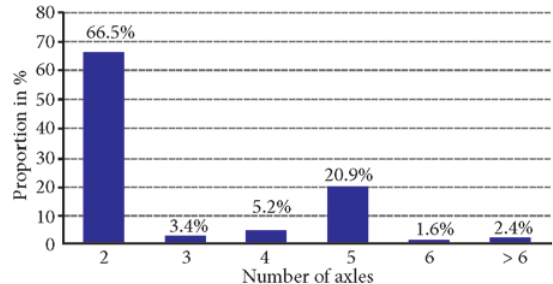
Fig. 3. Proportion of vehicles depending of the number of axles